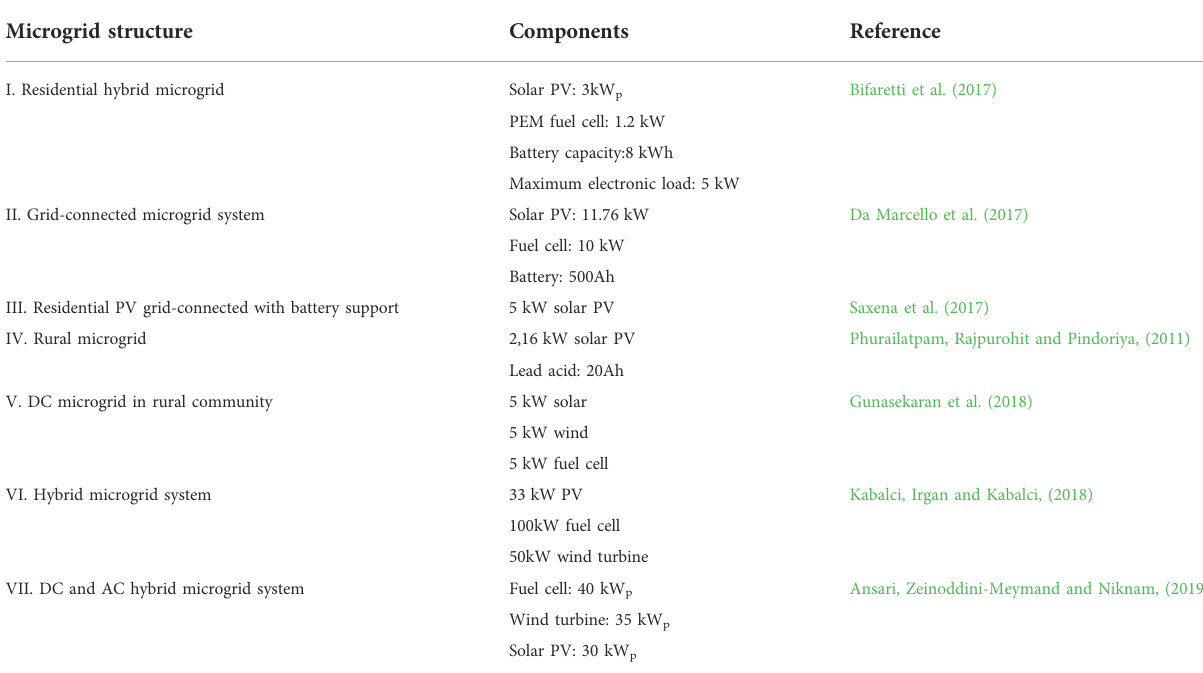
TABLE 1 Microgrid systems reviewed. Microgrid